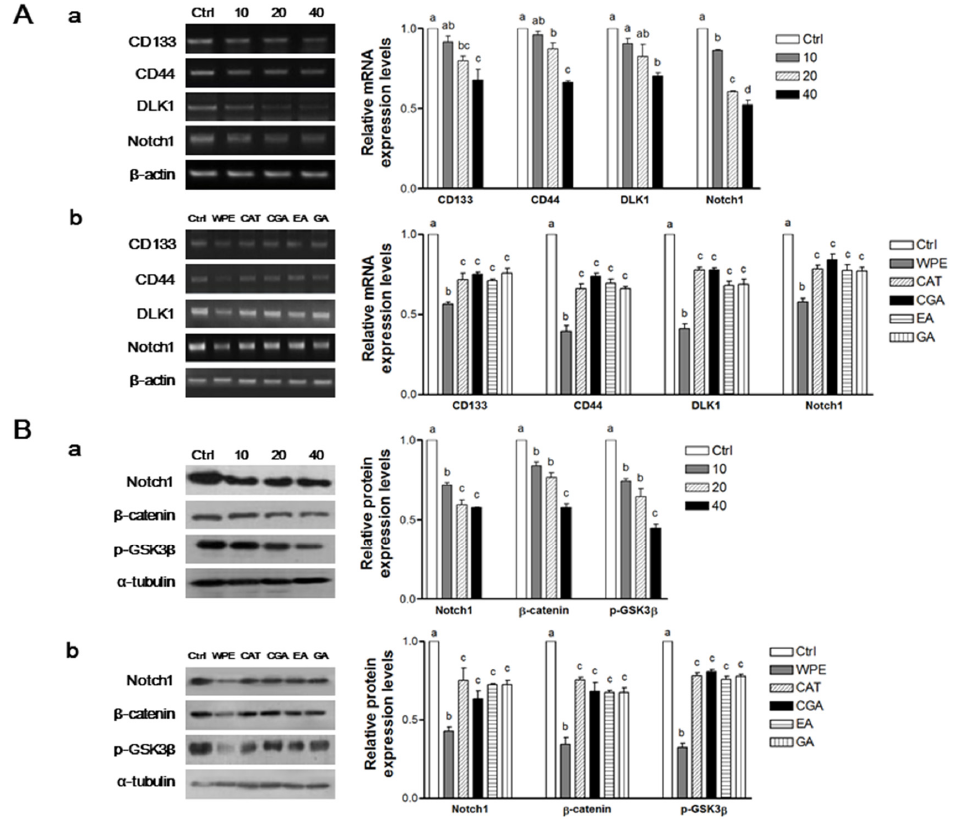
Figure 4. WPE and its bioactive compounds suppress colon CSCs markers, including CD133, CD44, DLK1, and Notch1 as well as Wnt/ β‐ catenin signaling in colon CSCs. CD133 + CD44 + HCT116 cells were treated with varying concentrations of WPE (0, 10, 20, and 40 μ g/mL) ( Aa , Ba ); or concentrations of (+) ‐ catechin, chlorogenic acid, ellagic acid and gallic acid comparable to 40 μ g/mL of WPE ( Ab , Bb ) for 6 days. mRNA expressions of CD133, CD44, DLK1 and Notch1 were examined by RT ‐ PCR, and β‐ actin was used as a loading control ( A ); Protein levels of Notch1, β‐ catenin and p ‐ GSK3 β were examined by Western blot analysis, and α‐ tubulin was used as a loading control ( B ). Representative blots are shown in left panel and quantified in right panel. The values shown are the means ± SEM. A p ‐ value < 0.05 was considered significant. Ctrl, Control; WPE, walnut phenolic extract; CSCs, cancer stem cells; CAT, (+) ‐ catechin; CGA, chlorogenic acid; EA, ellagic acid; GA, gallic acid.